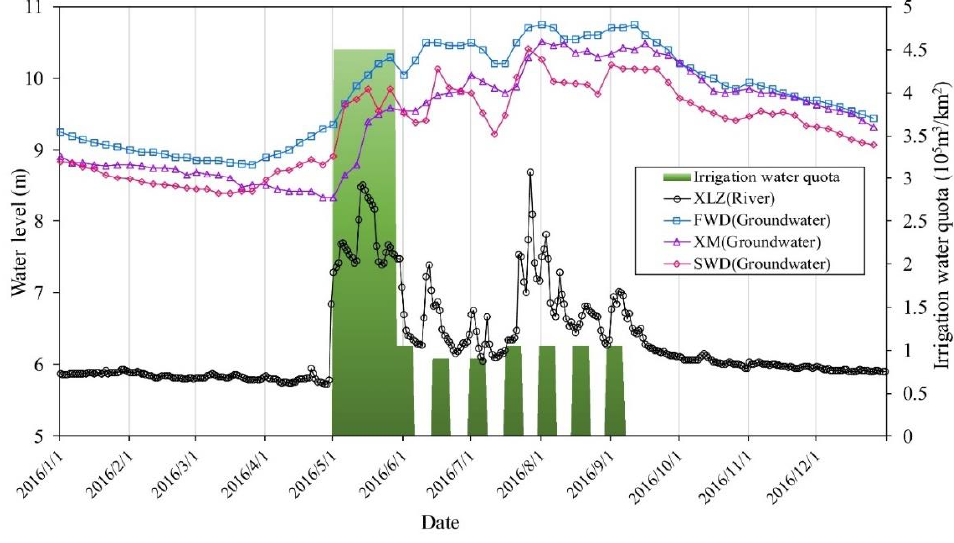
Figure 5. Changes in the irrigation water quota and level of the stream and groundwater.